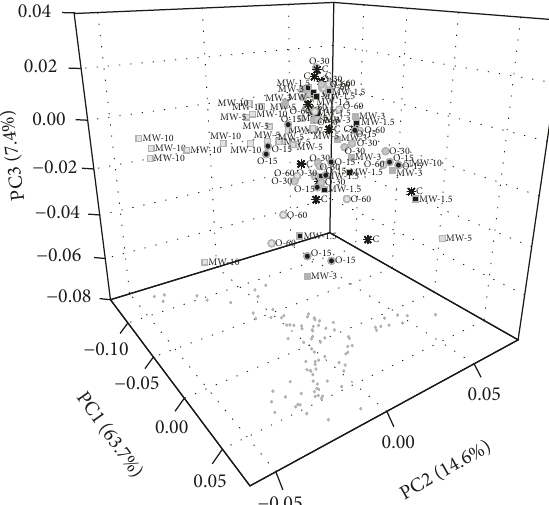
Figure 5: PCA results based on the 40 signal sensors profiles recorded by the homemade potentiometric E-tongue (3D plot of the first 3 PCs): microwave heating (MW, grey filled marks) for 1.5, 3, 5, or 10min (MW-1.5, MW-3, MW-5, or MW-10); oven heating (O, black filled marks) for 10, 30, or 60 min (O-10, O-30, or O-60); and unheated olive oils (control: C, asterisk